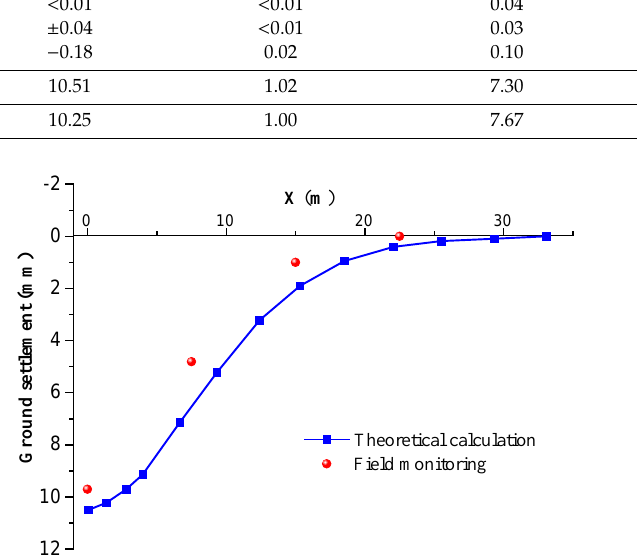
Figure 17. Total calculating displacement and field monitoring data.